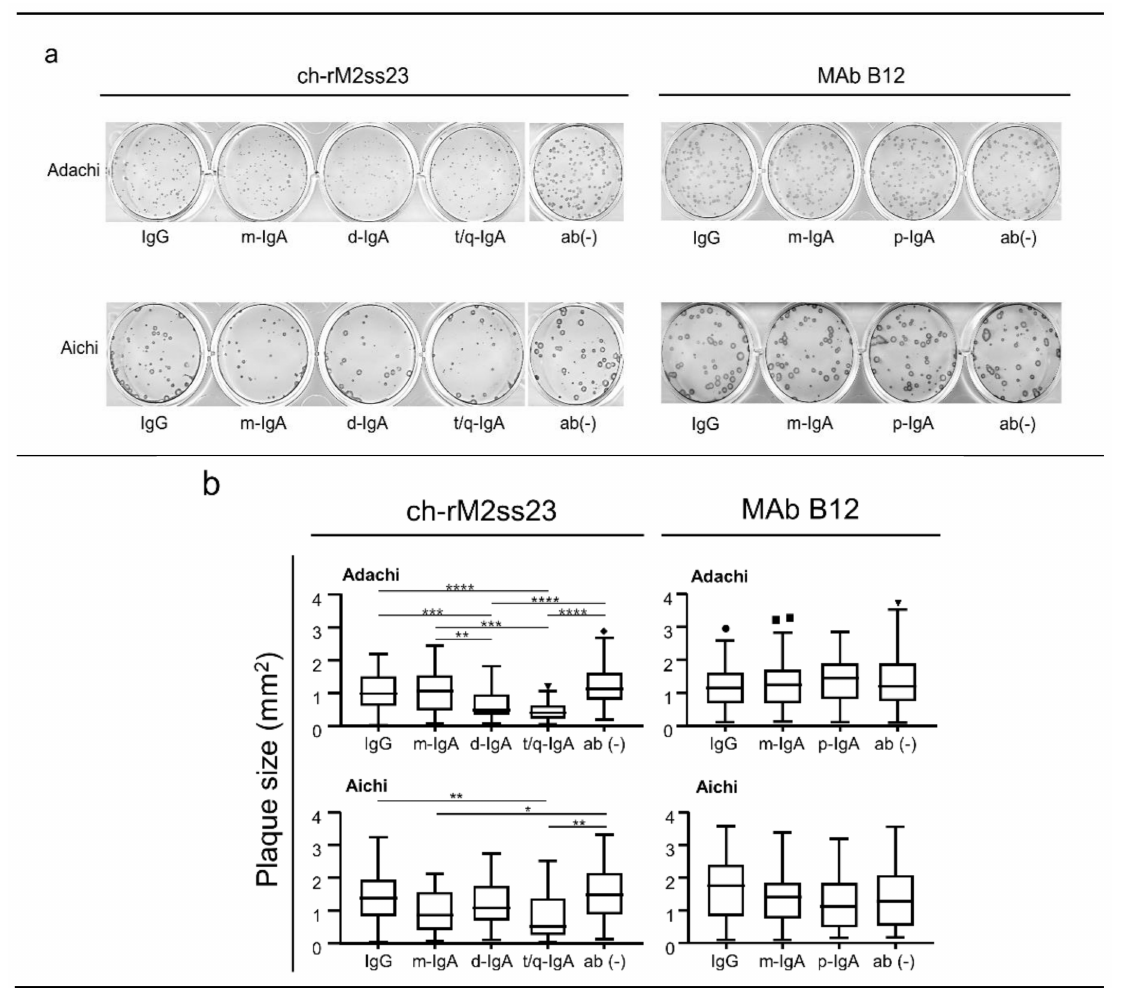
Figure 4. Reduced plaque sizes of IAVs in the presence of ch-rM2ss23 IgA antibodies. MDCK cells were infected with IAVs and incubated with or without MAb B12 and ch-rM2ss23 antibodies. Adachi- and Aichi-infected cells were incubated with MAbs at 10 µ g / mL and 0.5 µ g / mL, respectively. Plaques were stained as described in the Materials and Methods ( a ) and plaque sizes were measured for each well ( b ). Each box with a horizontal black line represents the interquartile range (IQR) and the median. The marks represent outlying plots located over 1.5 × IQR from the upper quartile. Whiskers extend from the highest and lowest values within a fence. Asterisks indicate significant di ff erences (* p < 0.05, ** p < 0.01, *** p < 0.001, **** p < 0.0001) determined using one-way ANOVA followed by Tukey’s multiple comparison